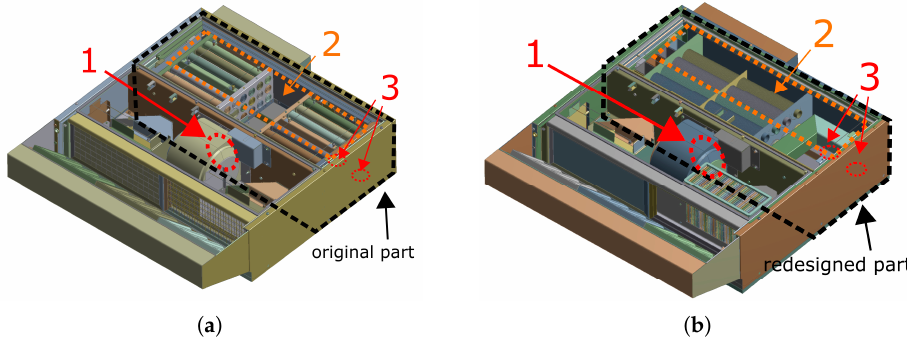
Figure 1. Condensation hood: ( a ) original construction; ( b ) redesigned construction; 1—fan outlet (coolant air inlet); 2—air outlet; 3—steam